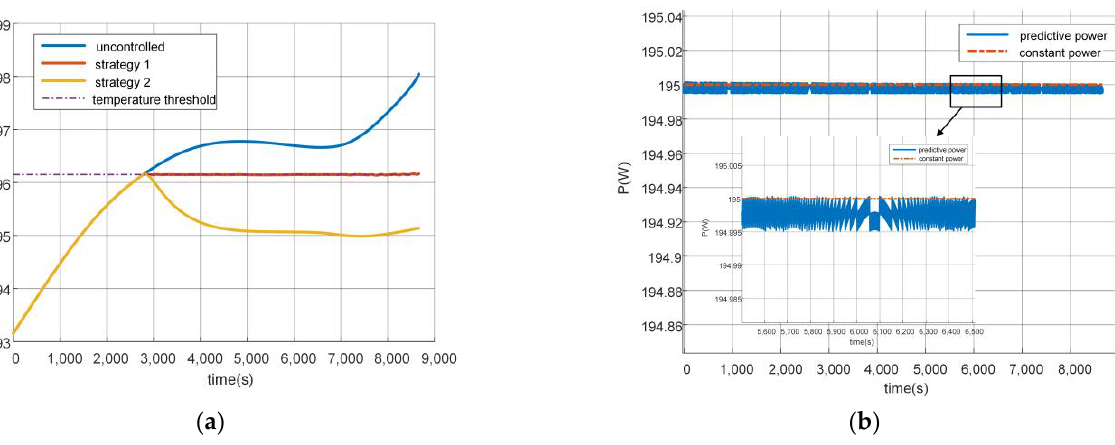
Figure 16. 195 W constant-power condition. ( a ) Temperature contrast. ( b ) Power comparison. Table 9. Simulation time per cycle for two strategies.